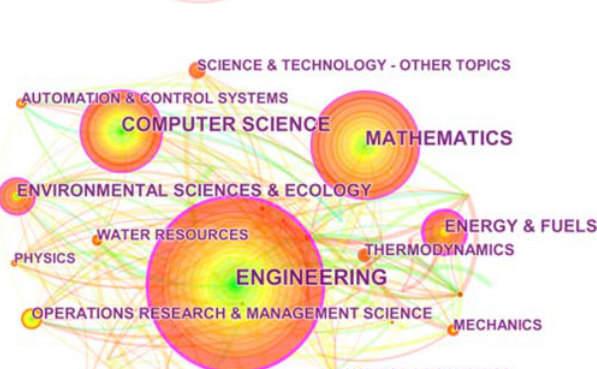
Figure 10. The categories in the grey relational literature